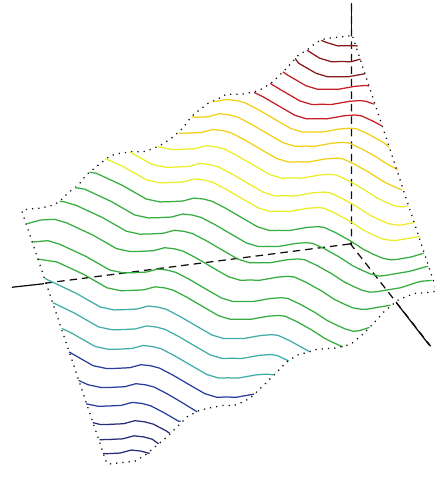
Figure 8: 𝑓(𝑥,𝑦) = sin (𝑥) + 𝑥 + 𝑦 .